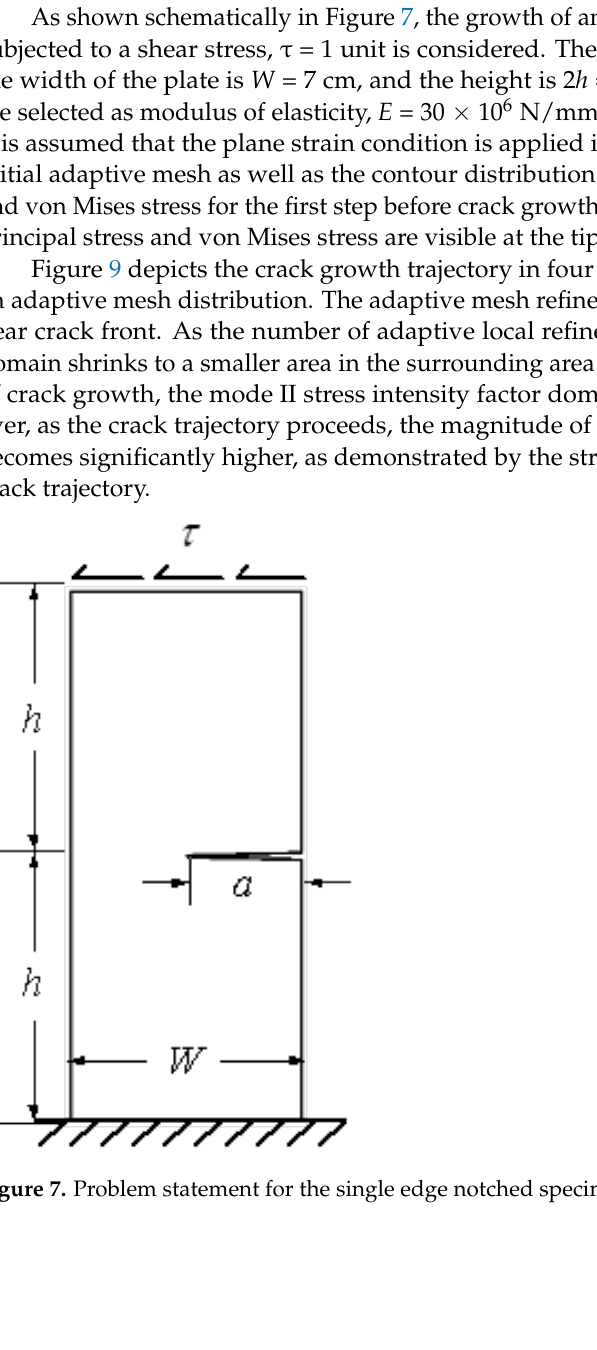
Figure 8. ( a ) The adaptive mesh, ( b ) maximum principal stress (MPa), and ( c ) von Mises stress (MPa). Figure 9 depicts the crack growth trajectory in four selected steps, each representing an adaptive mesh distribution. The adaptive mesh refinement initially occurs in local area near crack front. As the number of adaptive local refinements increases, the refinement domain shrinks to a smaller area in the surrounding area of the crack tip. At the beginning of crack growth, the mode II stress intensity factor dominated the crack direction. How- ever, as the crack trajectory proceeds, the magnitude of the mode I stress intensity factor becomes significantly higher, as demonstrated by the straight crack path at the end of the crack trajectory.